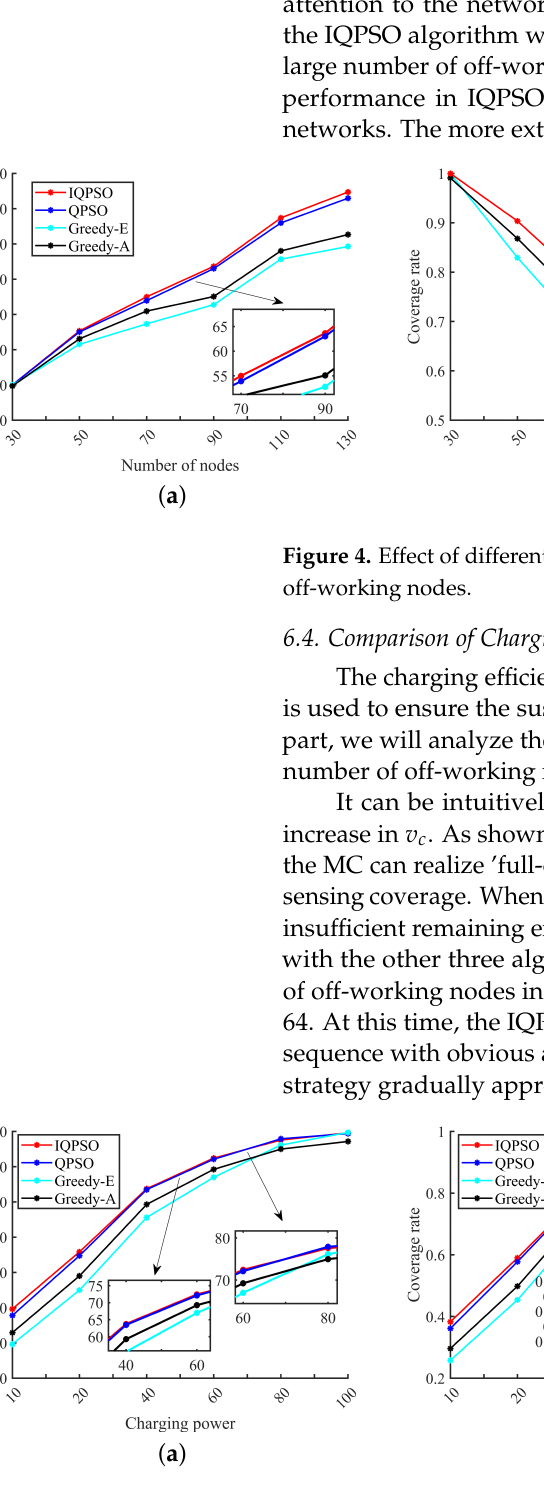
Figure 5. Effect of different MC charging powers. ( a ) Performance index. ( b ) Coverage rate. ( c ) Number of off-working